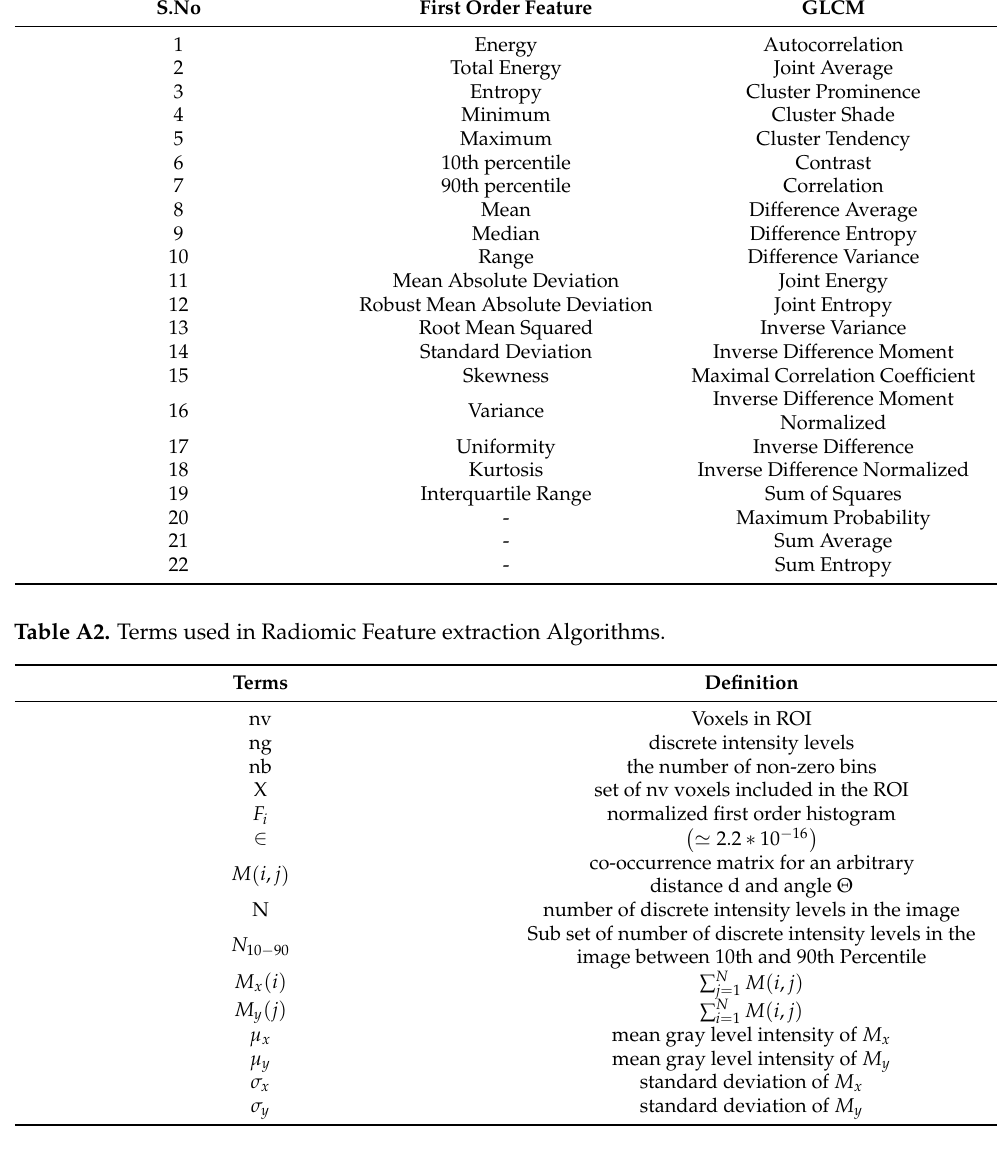
Table A3. Terms used in Fischer Score